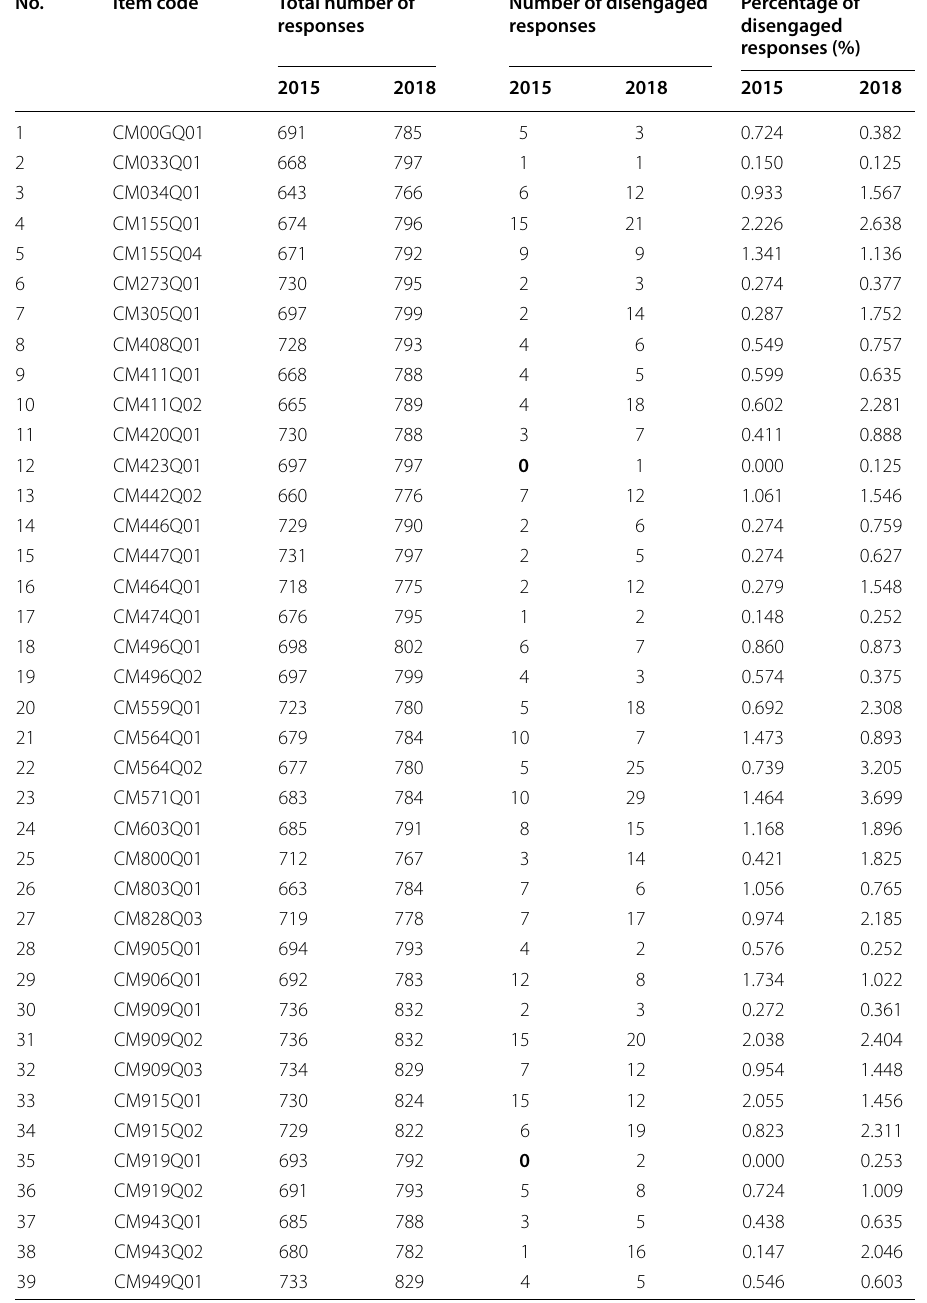
Table 2 Number and percentage of disengaged responses in 2015 and 2018. Source : Organisation for Economic Co-operation and Development (OECD), Programme for International Student Assessment (PISA), 2015 and 2018 Mathematics